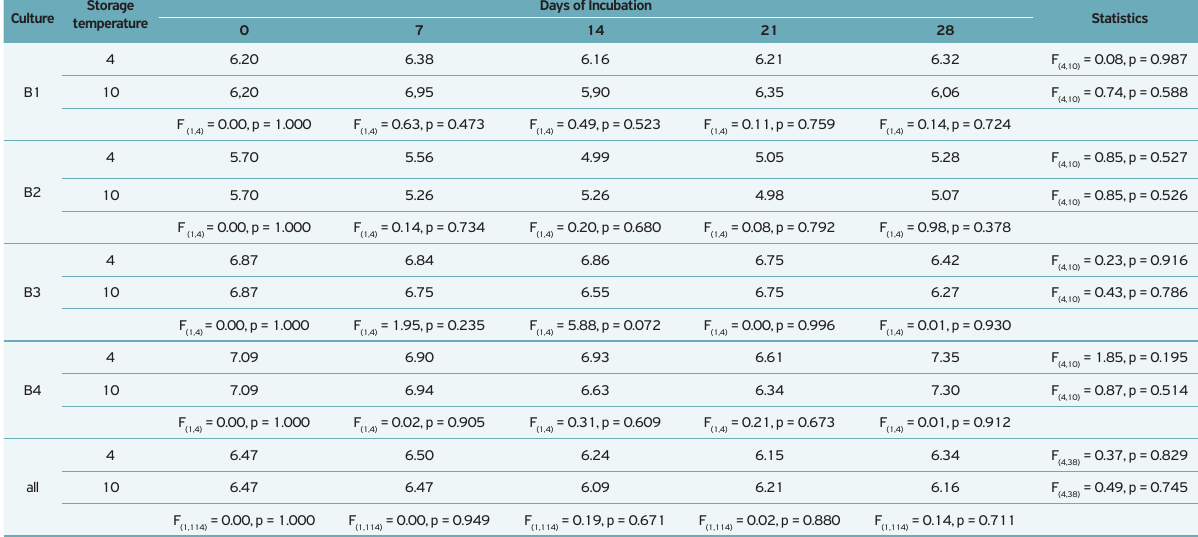
*All statistics presented: Analysis of Variance (ANOVA). Mean counts with distinct lower case indicate significant differences in a same row (Tukey test, p < 0.05). Mean counts with distinct upper case indicate significant differences in the same column (Tukey test, p < 0.05); nc = no counts recorded; F = ANOVA test; df = degrees of freedom; p = level of significance.